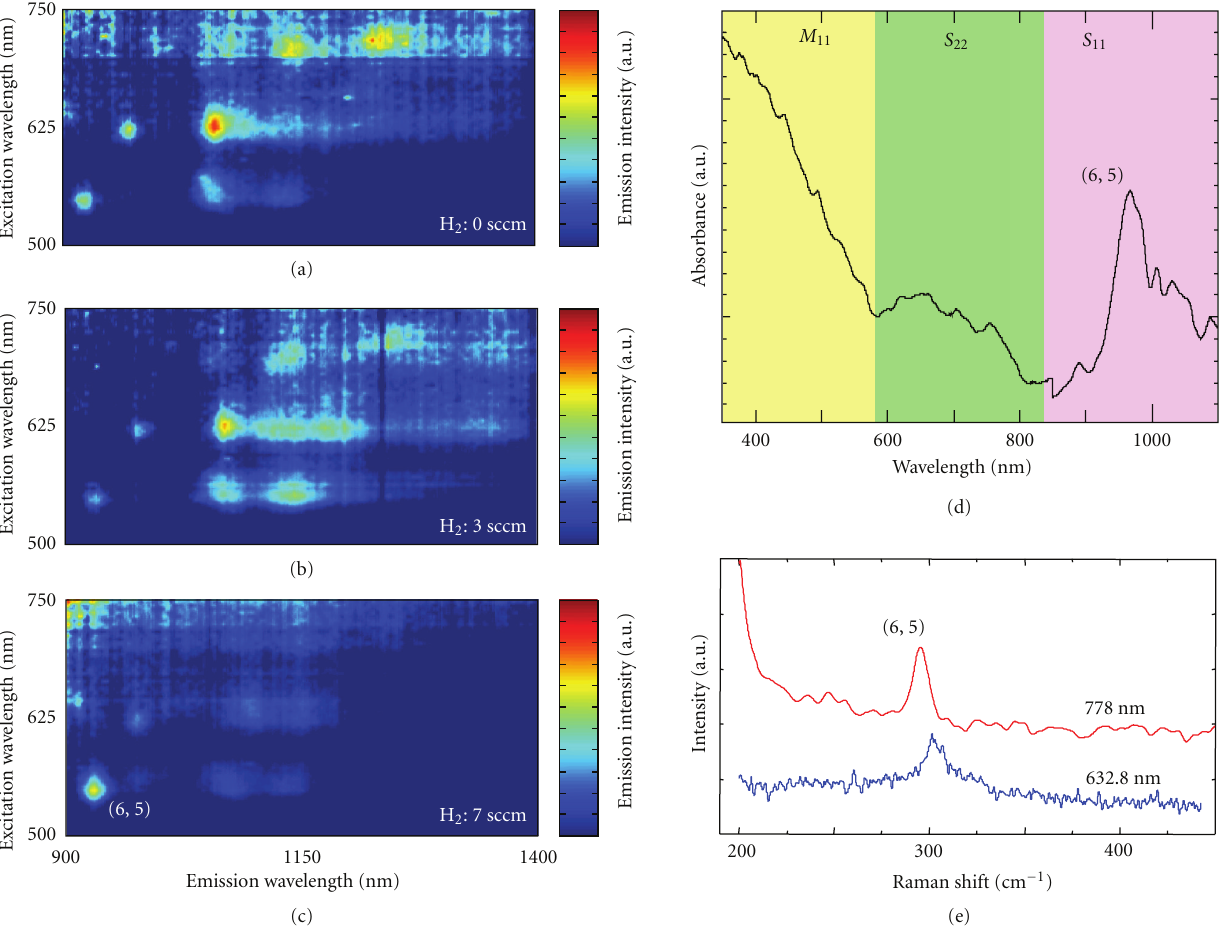
Figure 4: (a)–(c) PLE maps of SWNTs grown from an Au catalyst by plasma CVD under H 2 flow rates of (a) 0 sccm, (b) 3 sccm, and (c) 7sccm. (d) UV-Vis-NIR spectrum of SWNTs grown from an Au catalyst under a 7-sccm H 2 flow rate and (e) Raman spectra of as-synthesized SWNTs grown from an Au catalyst under a 7-sccm H 2 flow rate using excitation laser wavelengths of 632.8 nm and 778 nm.